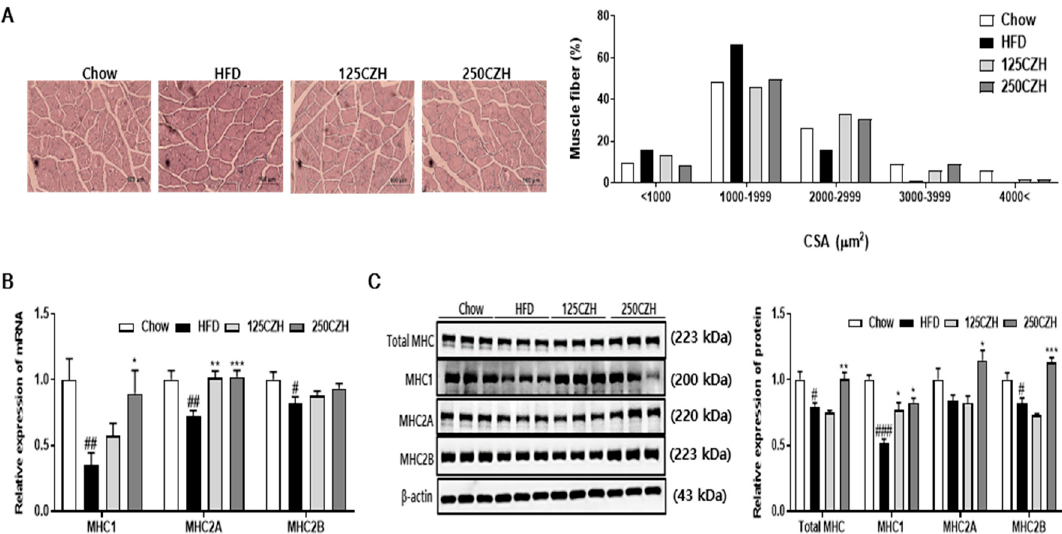
Figure 3. Effect of CZH on muscle fiber size and type in mice. ( A ) Representative image of myofiber cross-section of gastrocnemius muscle (hematoxylin and eosin staining; scale bar, 100 μ m). Images were analyzed by light microscopy, and cross-sectional area (CSA) was measured. Distribution of muscle fiber CSA ( n = 3 per group). ( B ) qRT-PCR analyses of MHC1, MHC2A, and MHC2B mRNA expression in quadriceps muscle. ( C ) Expression of total MHC, MHC1, MHC2A, and MHC2B in gastrocnemius muscle as determined by Western blotting. Band density was analyzed using ImageJ software (National Institutes of Health). Results are expressed as mean ± SEM ( n = 8). * p < 0.05, ** p < 0.01, *** p < 0.001 versus the HFD group. # p < 0.05, ## p < 0.01, ### p < 0.001 vs. the Chow-fed group.